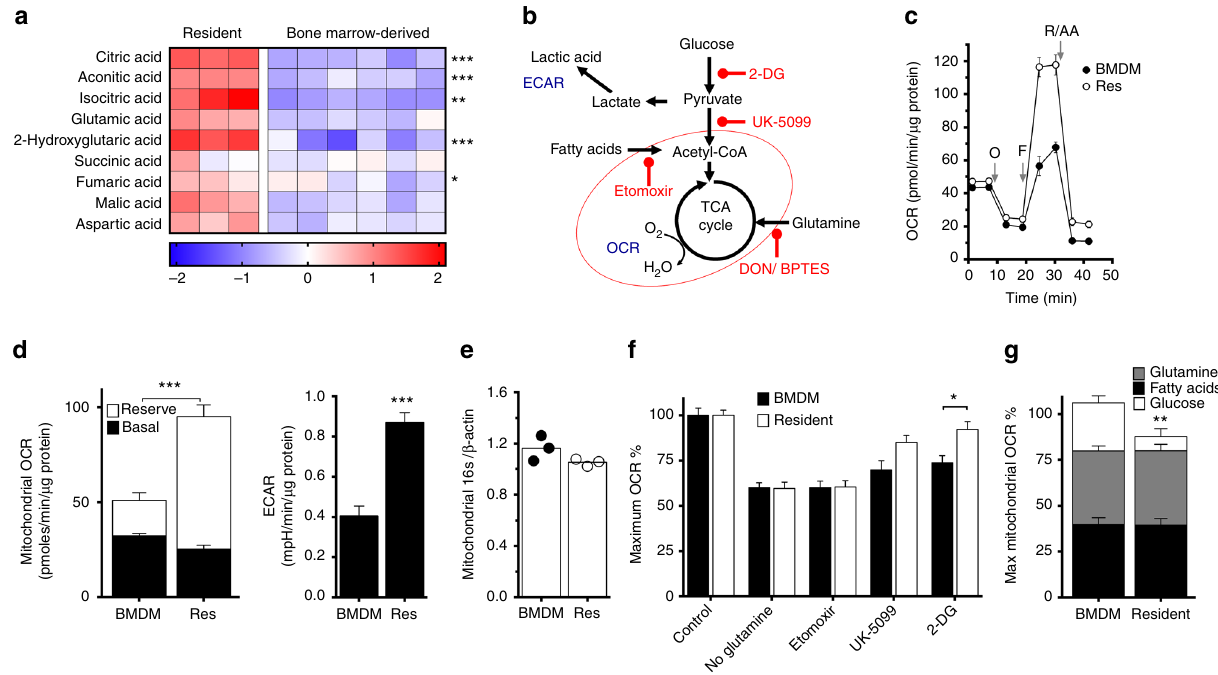
Fig. 1 Peritoneal tissue-resident macrophages are highly oxidative and are fuelled by glutamine. a Heat-map showing the log10 difference from the average metabolite peak areas from gas chromatography-mass spectrometry, which are associated with the citric acid cycle from peritoneal tissue-resident macrophages (pTRMØ, Res) and bone marrow-derived macrophages (BMDM). Data show 3 – 6 independent samples per group analysed by two-way ANOVA (interaction < 0.0001) with Sidak ’ s post-tests. b Schematic showing a simpli fi ed metabolic pathway detailing readouts for extracellular acidi fi cation rate (ECAR), oxygen consumption rate (OCR) and drugs, which inhibit these pathways, the red oval indicates the mitochondria. c Graph showing representative Seahorse mitochondrial stress tests, O = oligomycin (1.26 μ M), F = FCCP (0.67 μ M), R/AA = Rotenone (0.2 μ M) + antimycin A (1 μ M). d Bar graphs showing quanti fi ed protein-normalised ECAR and mitochondrial OCR from stress tests in c , combination of the two OCR parameters represents the maximum mitochondrial capacity. Data ( n = 3 separate wells per group) represent three experiments, OCR data were analysed by paired two-way ANOVA (interaction p < 0.0001) with Sidak ’ s post-tests for the difference between pTRMØ and BMDM (reserve/ maximal mitochondrial capacity) or by Student ’ s t -test (ECAR). e Bar graph depicting the ratio of mitochondrial 16s deoxyribonucleic acid (DNA) vs β -actin DNA in three independent samples, data was not signi fi cant by Student ’ s t -test. f Bar graph showing the drop in maximum decoupled mitochondrial OCR after addition of drugs or withdrawal of fuels. Glucose dependence was assessed using 2-deoxyglucose (2-DG, 100 mM), pyruvate using UK-5099 (20 µ M), a mitochondrial pyruvate transport inhibitor, long-chain fatty acids by etomoxir (100 μ M) and glutamine by 1 h starvation before reintroduction of glutamine (2 mM) or control media. g Stacked bar graph showing a breakdown of the effects of different metabolic fuels on maximum mitochondrial capacity from f . Data f and g ( n = at least 3 separate wells per group) represent at least two experiments, and were analysed by two-way ANOVA ((G) interaction p = 0.02; (F) interaction p = 0.056, cell p = 0.017, fuel p < 0.0001) with Sidak ’ s post-tests. All error bars denote mean ±